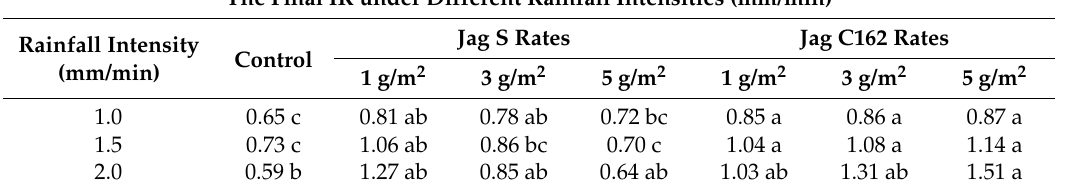
Table 3. The final infiltration rate (IR) under different rainfall intensities. The Final IR under Different Rainfall Intensities (mm/min)